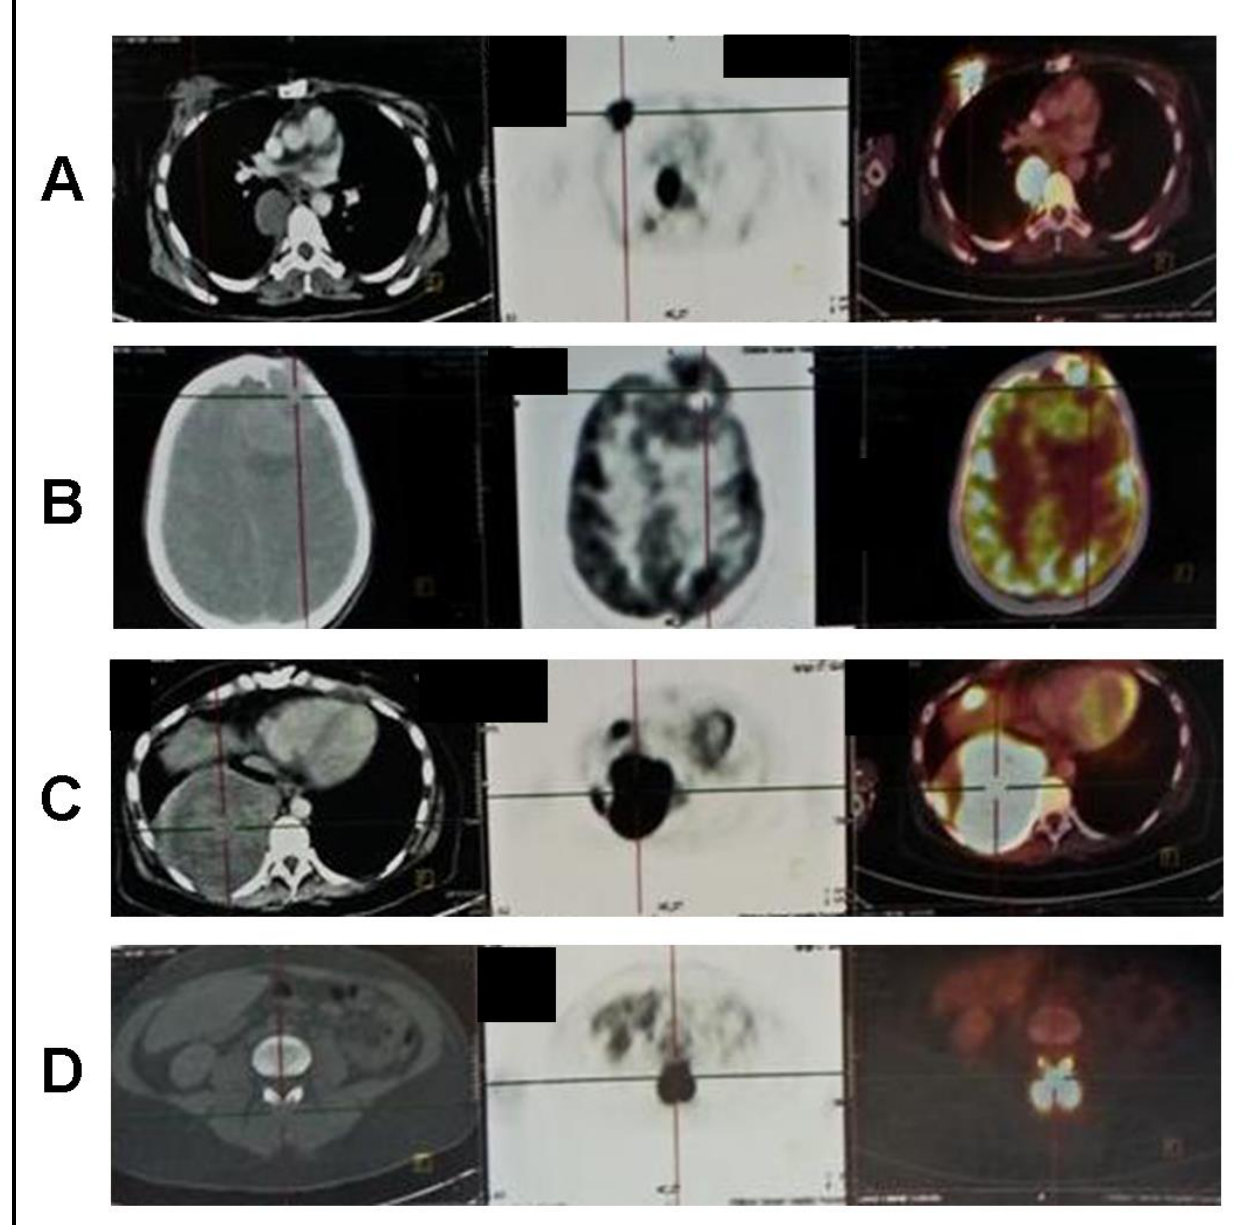
Figure 1. Positron emission tomography–computed tomography (PET-CT) scan images showing: A- Right chest wall recurrence, B- Brain metastasis, C- Lung metastasis and D- Bone